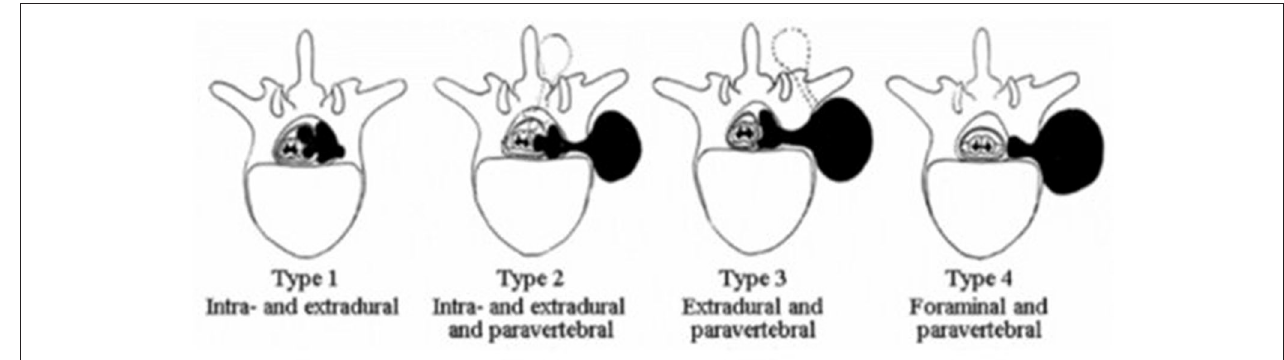
FIGURE 1 | Eden’s classification of spinal dumbbell tumors, from left to right: type I–rumors with intra- and extradural components; type II–with intra-, extradural, and paravertebral components, type III–with extradural and paravertebral components, type IV–with foraminal and paravertebral